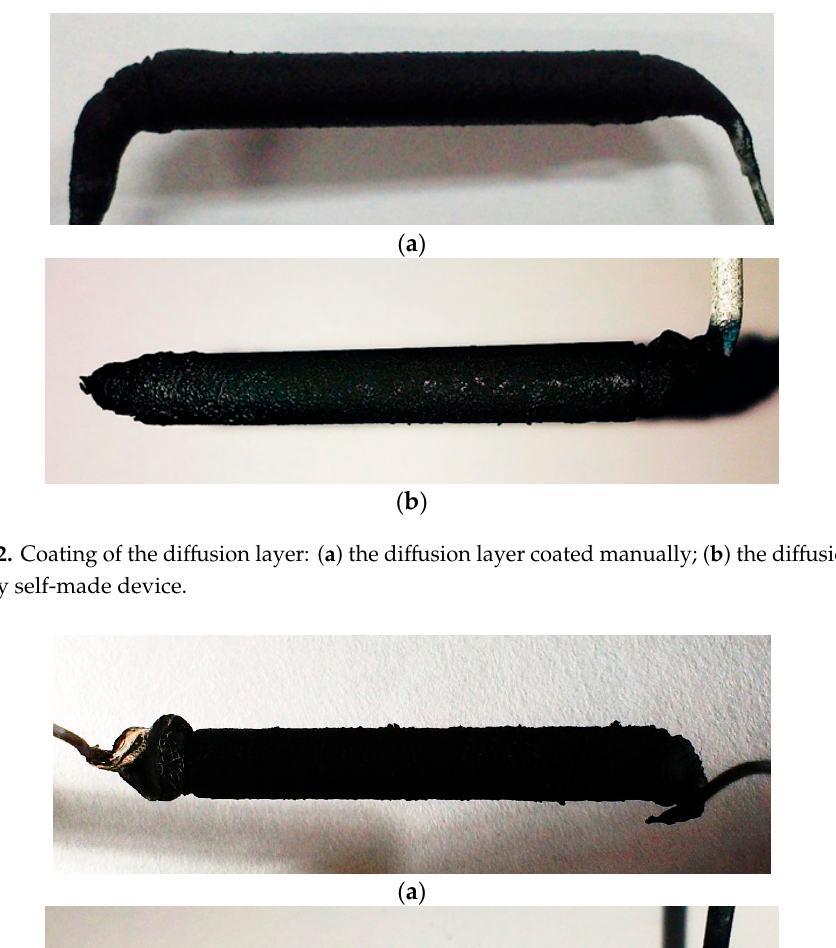
Table 4. Optimal experimental parameters.